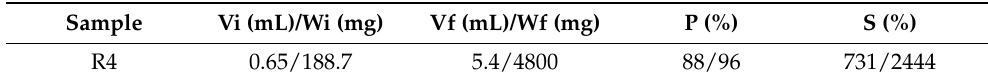
Table 1. Results from the swelling